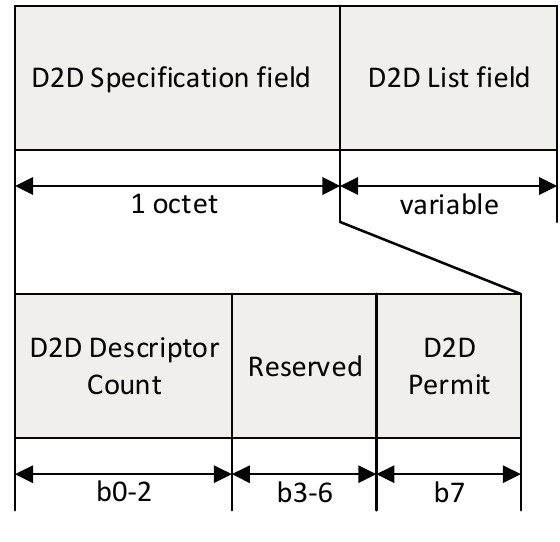
Figure 7. The format of the D2D